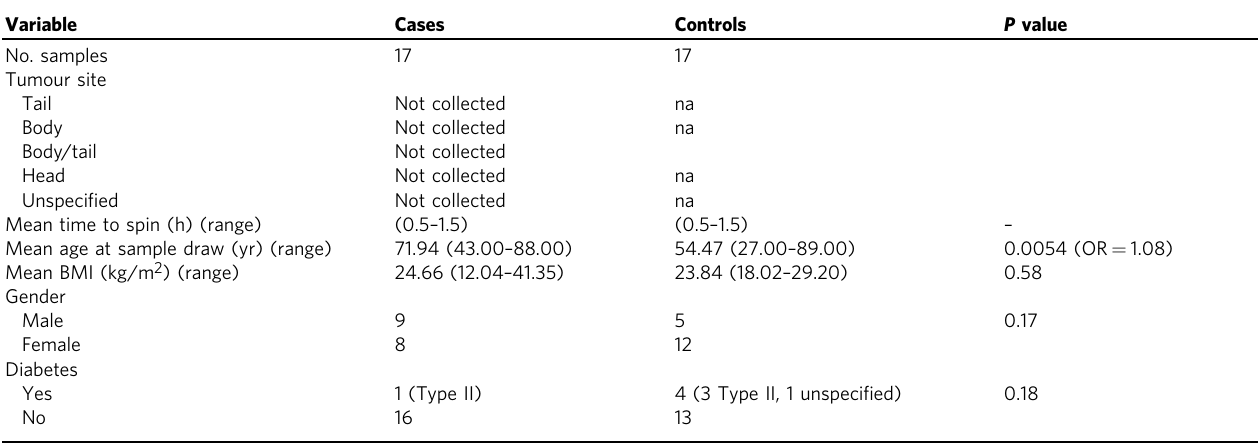
Table 2 External validation set